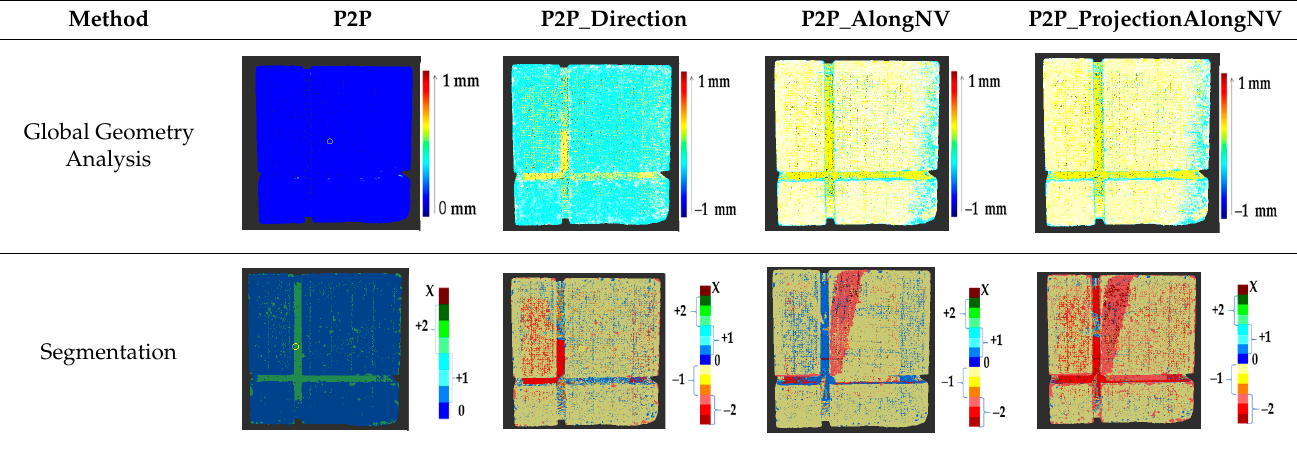
Table 14. Analysis of surface points count on the surface of ES1.